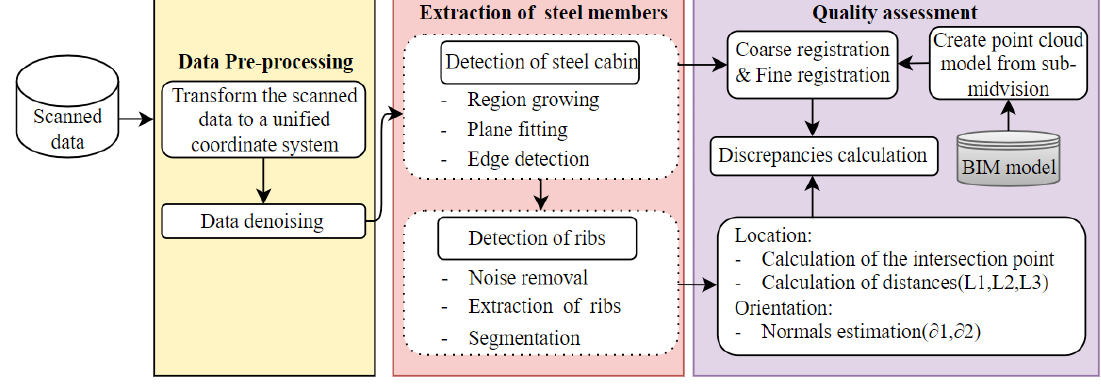
Figure 1. Flowchart of the proposed method for geometric quality assessment procedures.